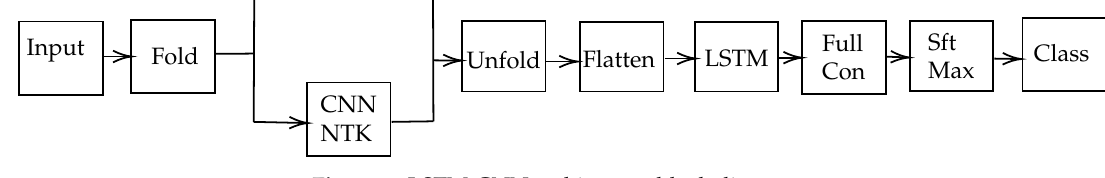
Figure 7. LSTM-CNN architecture block diagram.